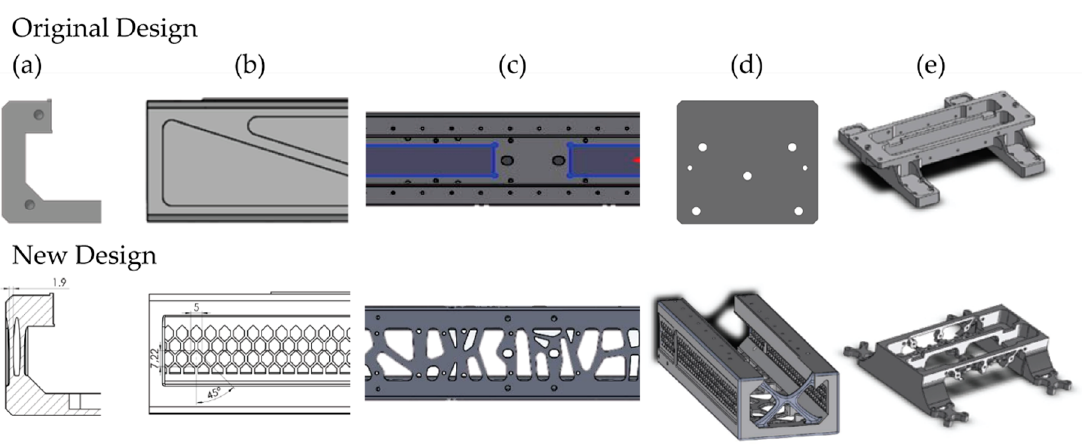
Figure 3. Details of the redesigned features for ( a, b, c, d ) the X-rail and ( e ) the Y-rail.